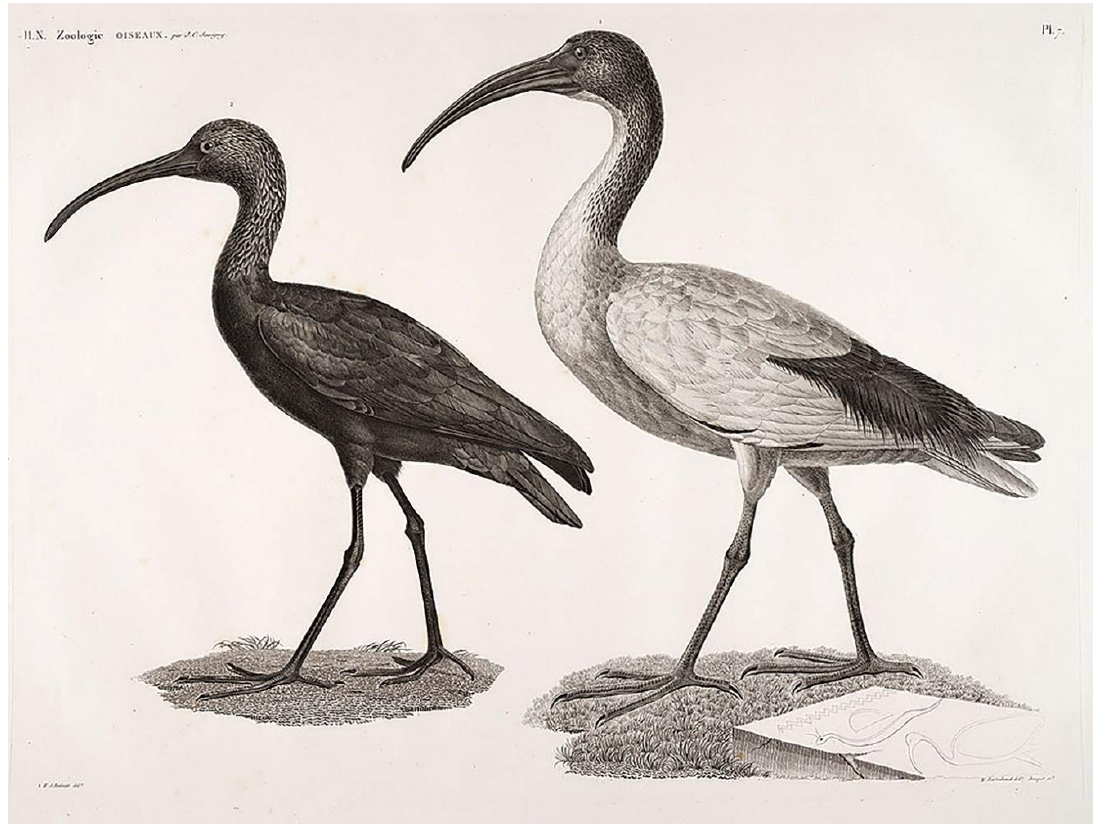
Figure 1. Illustration depicting the Black (Glossy) Ibis ( Plegadis falcinellus ) and the Sacred Ibis Figure1. IllustrationdepictingtheBlack(Glossy)Ibis( Plegadisfalcinellus )andtheSacredIbis( Threskiornis (Threskiornis aethiopicus) from the Description de l’Égypte Histoire naturelle , v.1, published in 1809. aethiopicus ) from the Description de l’ É gypte Histoire naturelle , v.1, published in